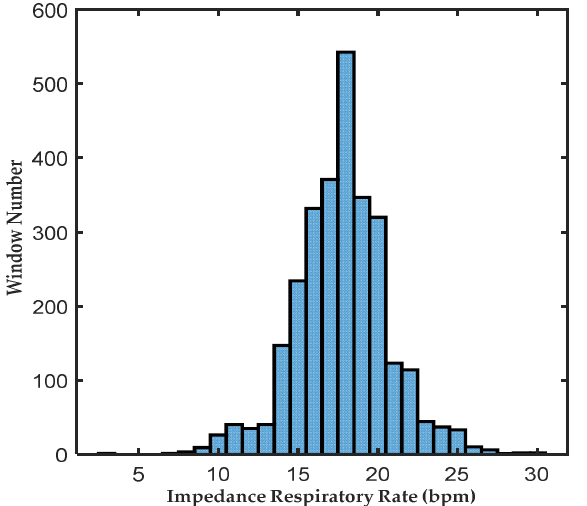
Figure 2. Distribution of each 32-s PPG window corresponding to the RR I . The horizontal axis indicates the value of the RR I for each 32-s window, and the vertical axis indicates the number of windows at the corresponding RR I .